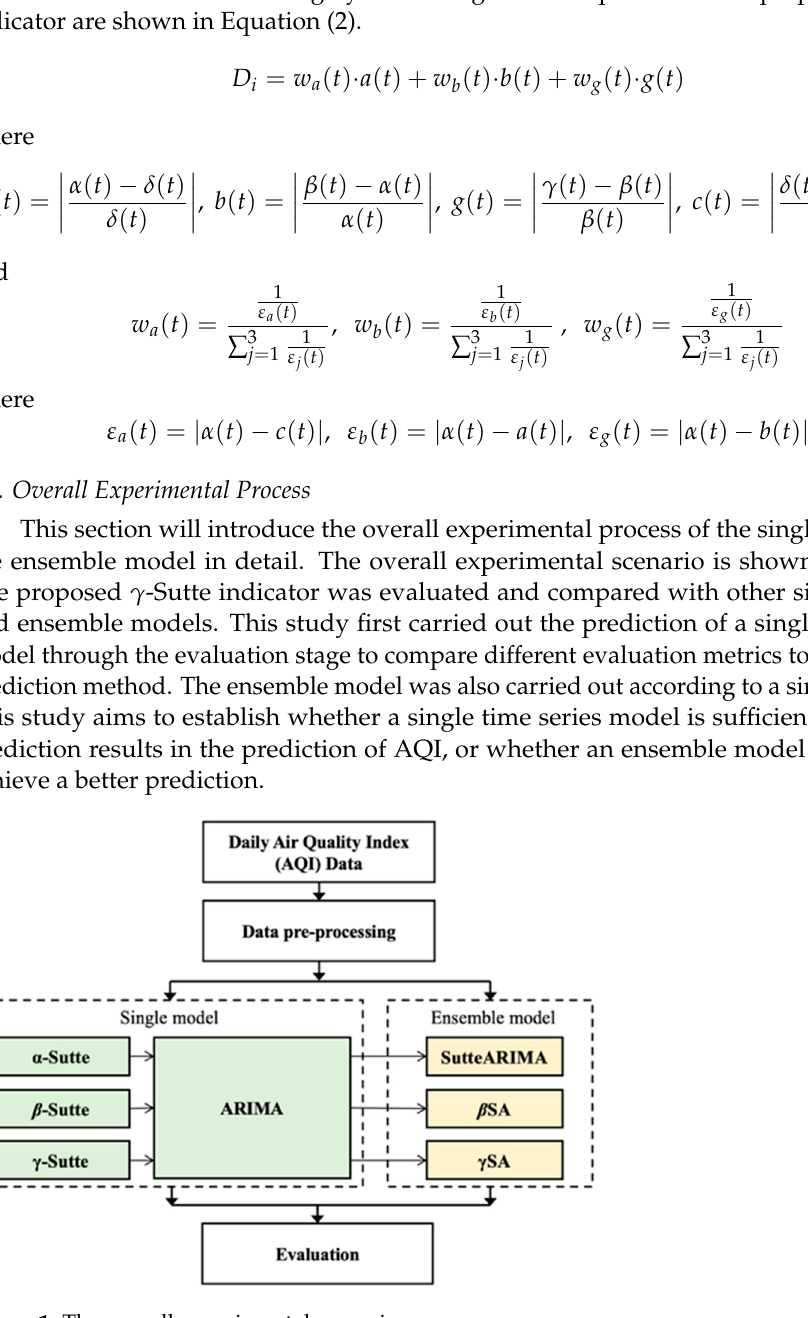
Figure 1. The overall experimental scenario.